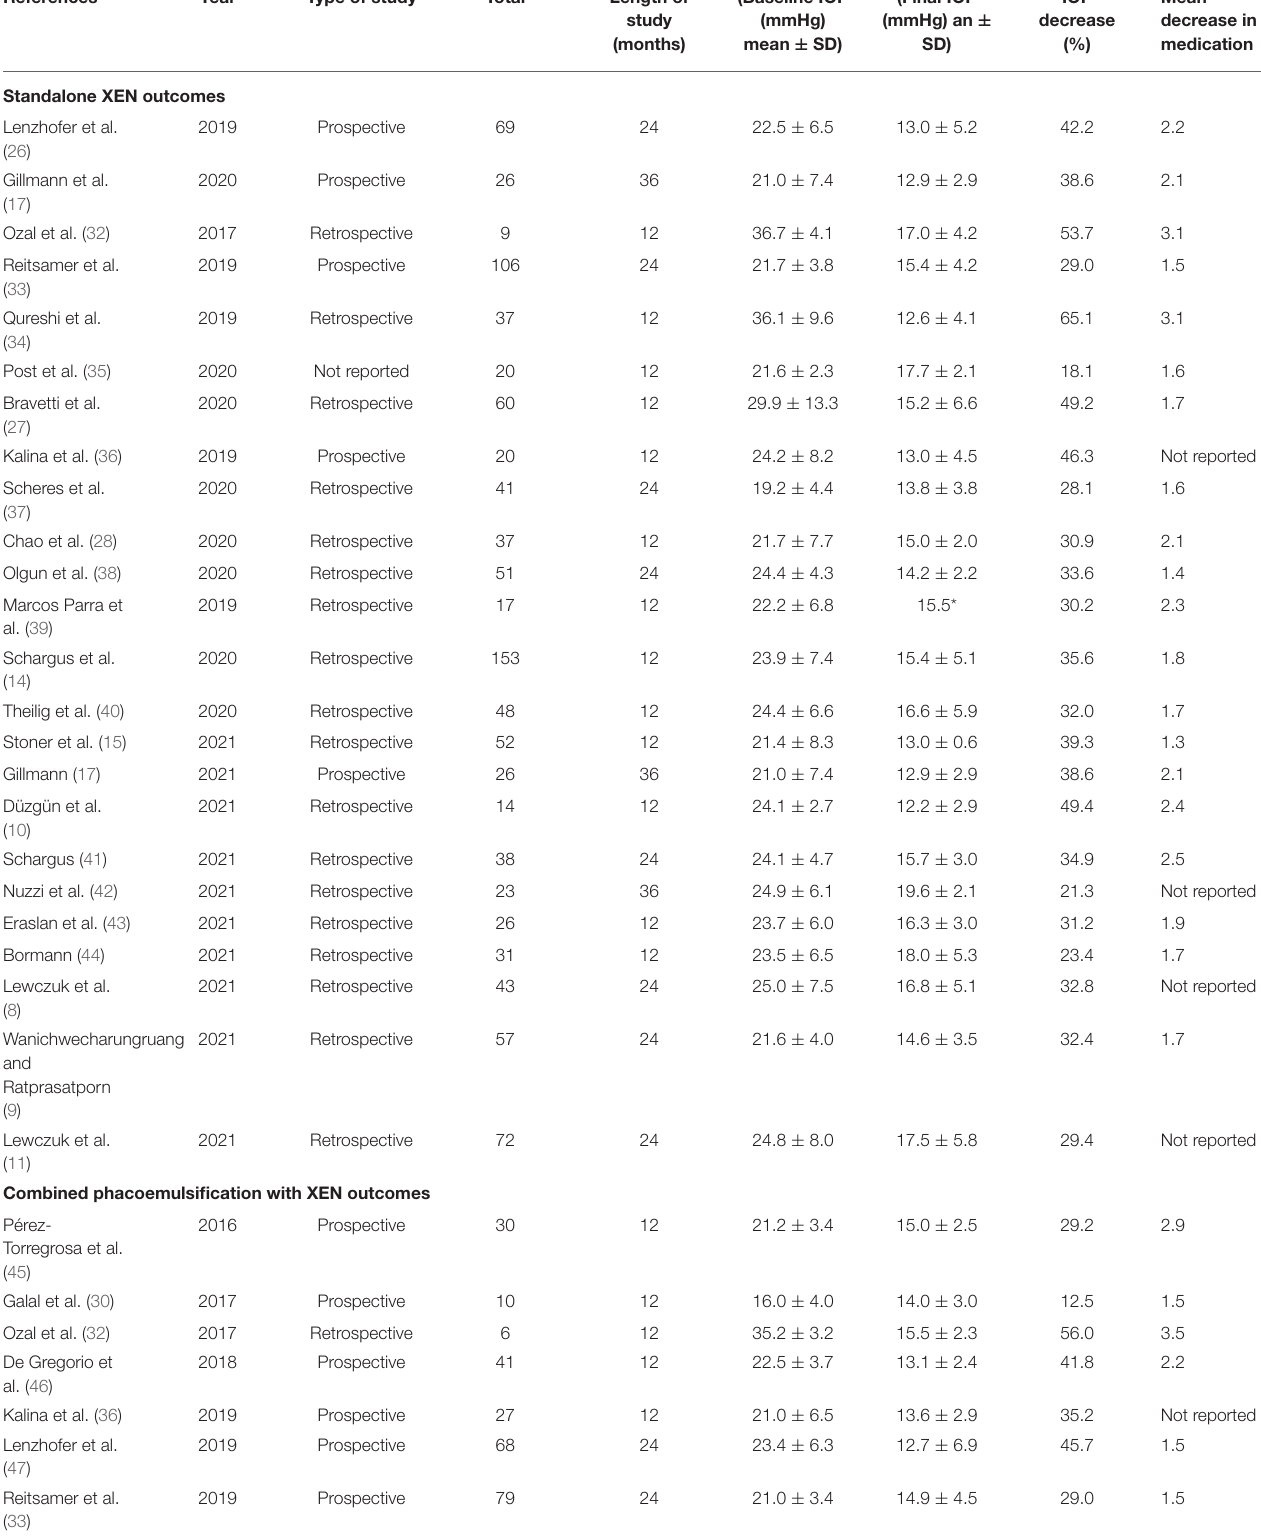
TABLE 1 | Intraocular pressure (IOP) and medication outcomes following XEN